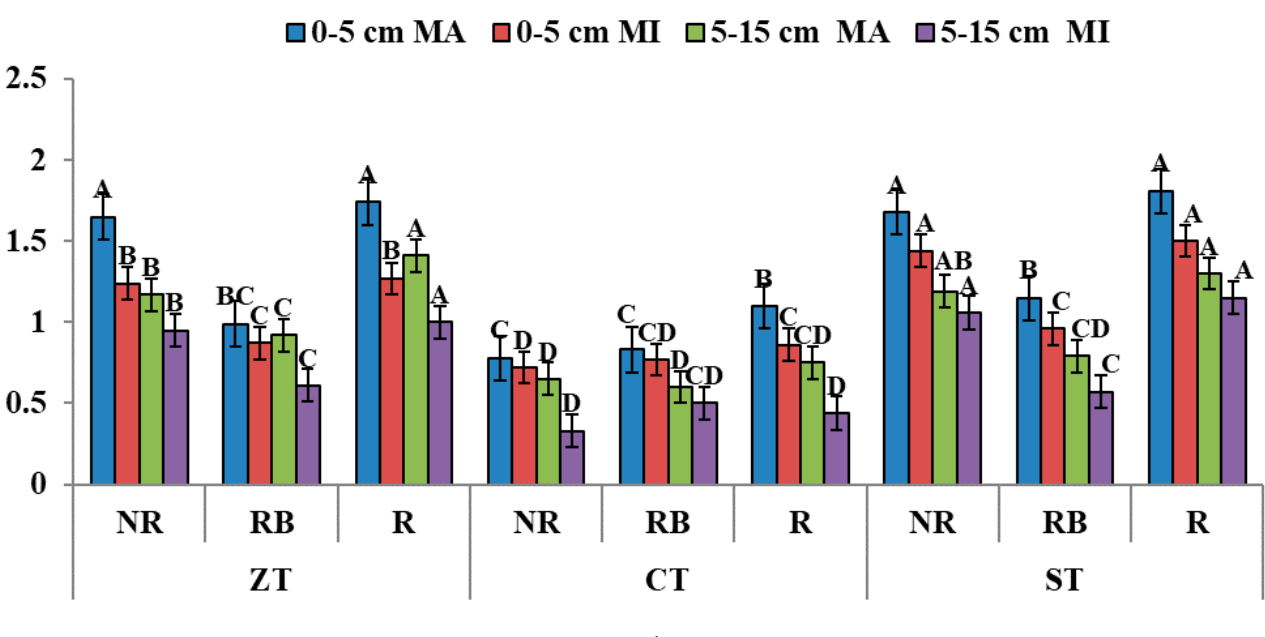
parameter column show significant differences at p ≤ 0.05 by Duncan’s Multiple Range Test.